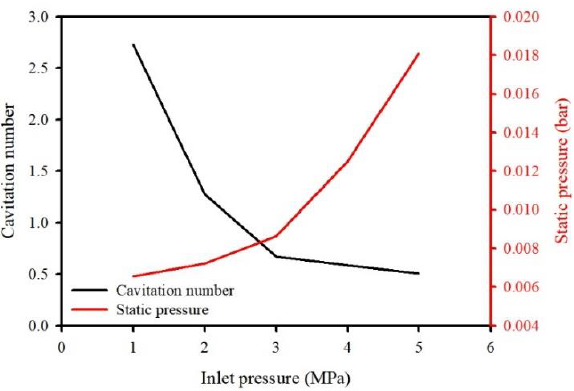
Figure 2. The hydrodynamic condition presented as the effect of inlet pressure on cavitation number and static pressure.